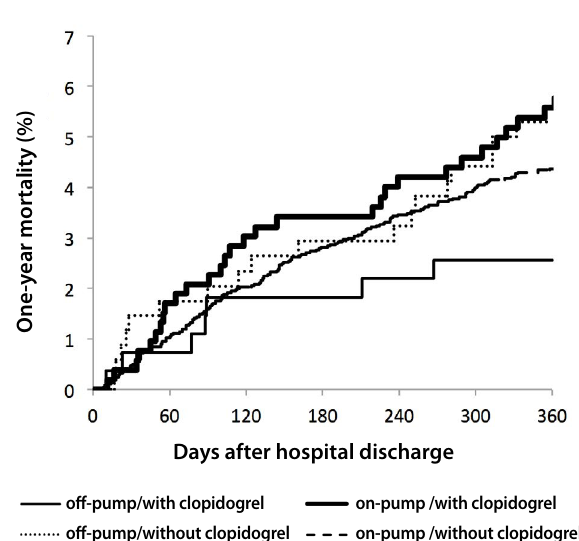
Fig. 2 – One-year mortality according to the clopidrogel use after on-pump and off-pump CABG